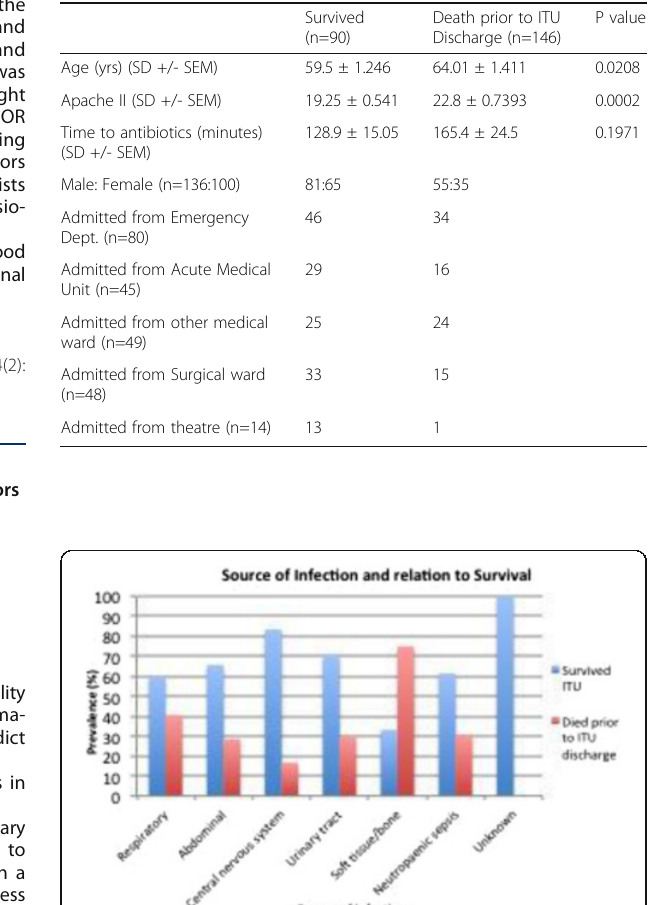
Table 41 (abstract A112). Demographic Data